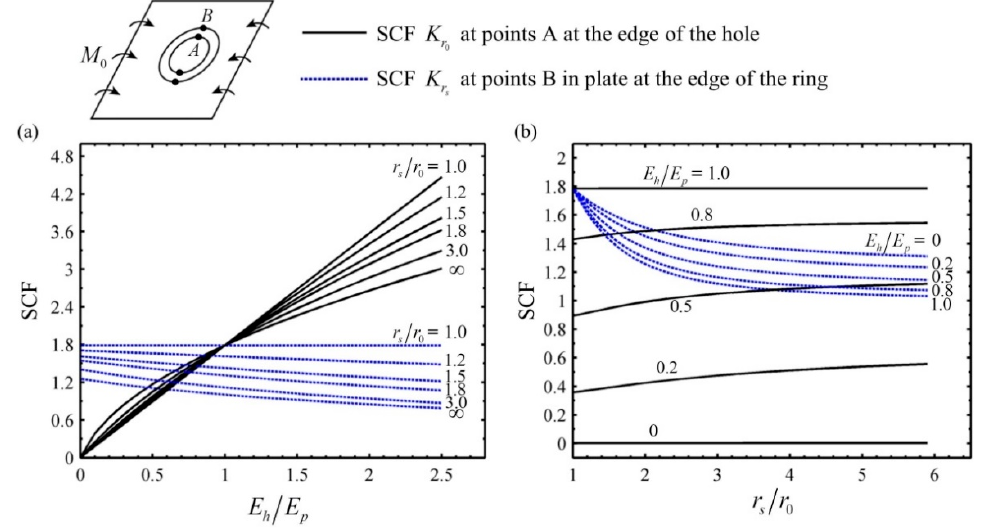
Figure 8. Stress concentration factor (SCF) for a homogeneous plate with a circular hole reinforced with a linear FGM ring: ( a ) variation of SCF with h p E E ; ( b ) variation of SCF with